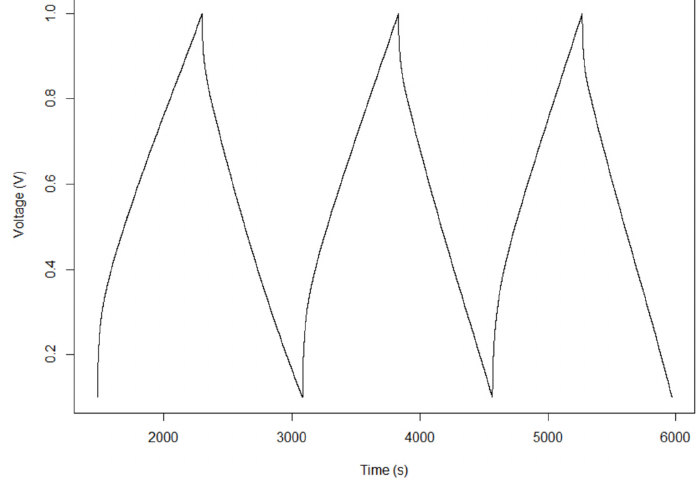
Figure 2. Example of raw, constant current data for capacitor 1. ( a ) Ten cycles, with a DT of ~9 s. ( b ) In this and all other cases dielectric constants computed for three regions, by voltage; I: 1.6–2.3; II: 0.8–1.6; and III: 0.1–0.8 V. These regions show nearly linear change in voltage for a constant